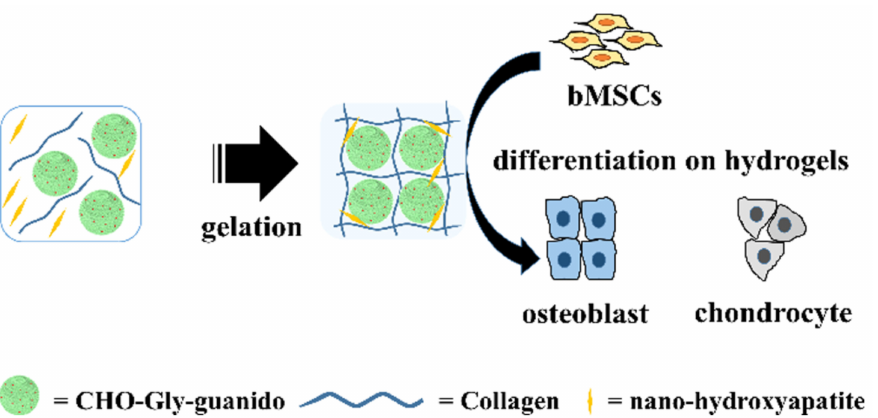
Figure 3. The process of using the flexible crosslinking nature of glycogen to produce a nanohy- droxyapatite/collagen scaffold for the differentiation of bone and cartilage tissue. Reprinted with permission from Zhang et al. [83]. Copyright © American Chemical